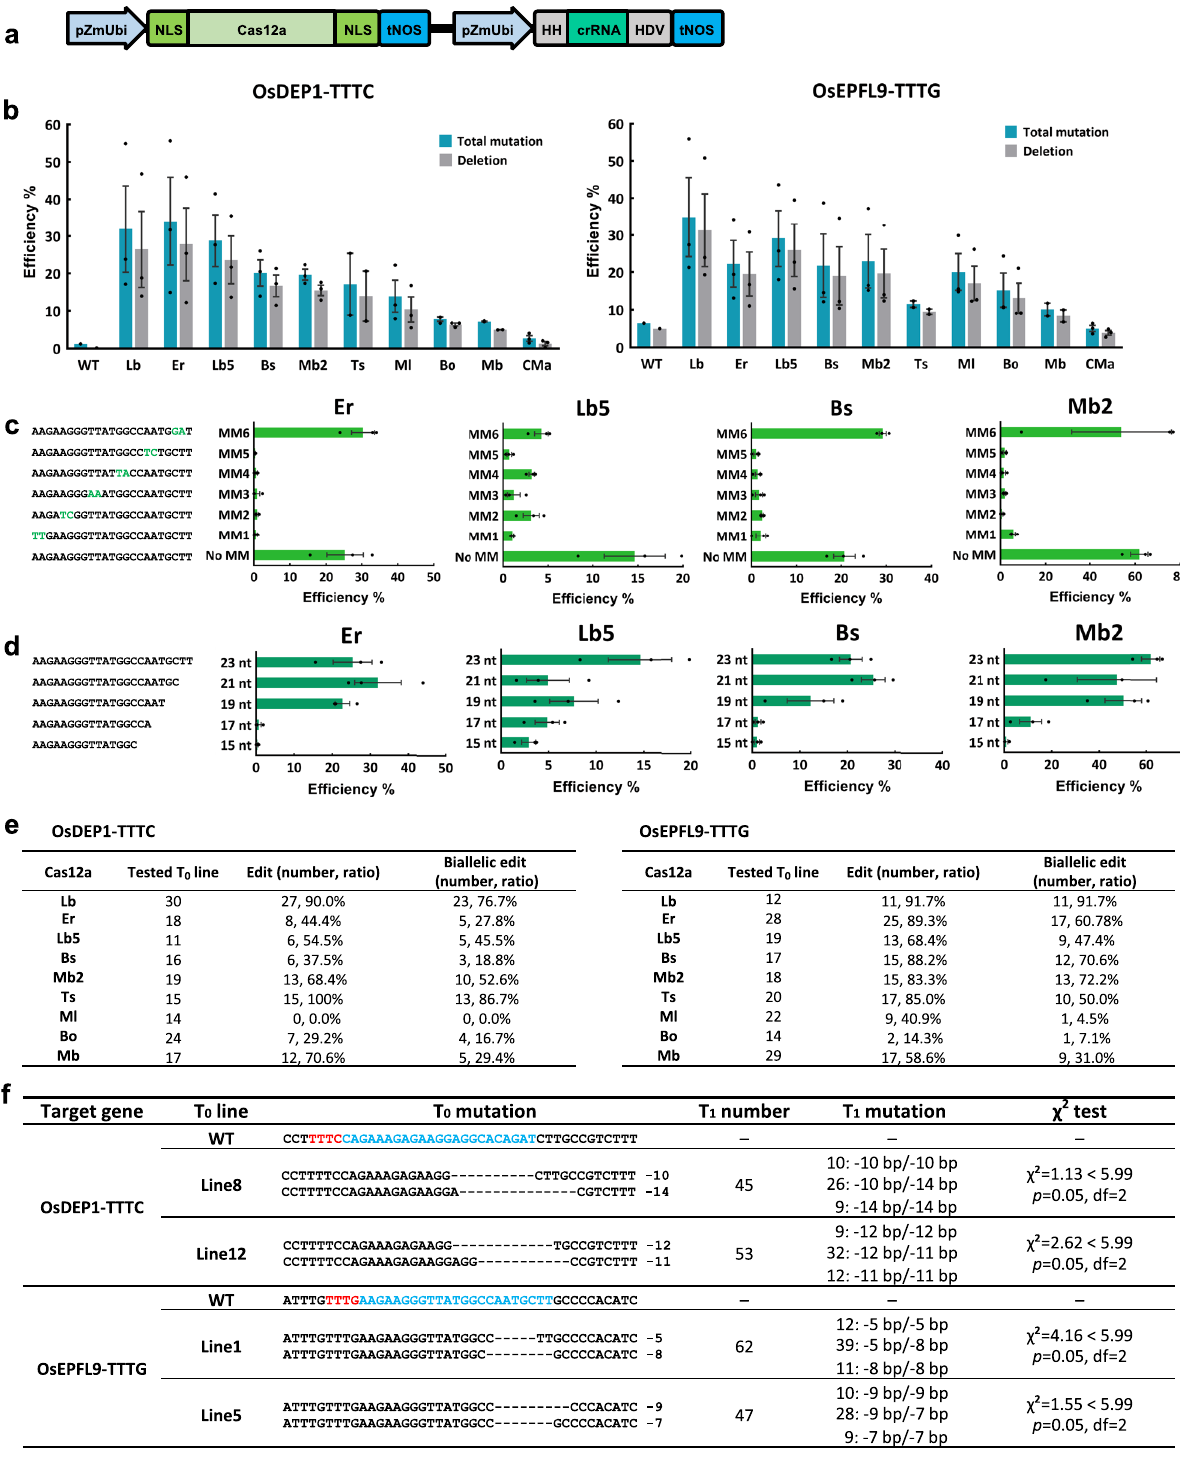
NATURE COMMUNICATIONS| (2021) 12:1944 |https://doi.org/10.1038/s41467-021-22330-w|www.nature.com/naturecommunications